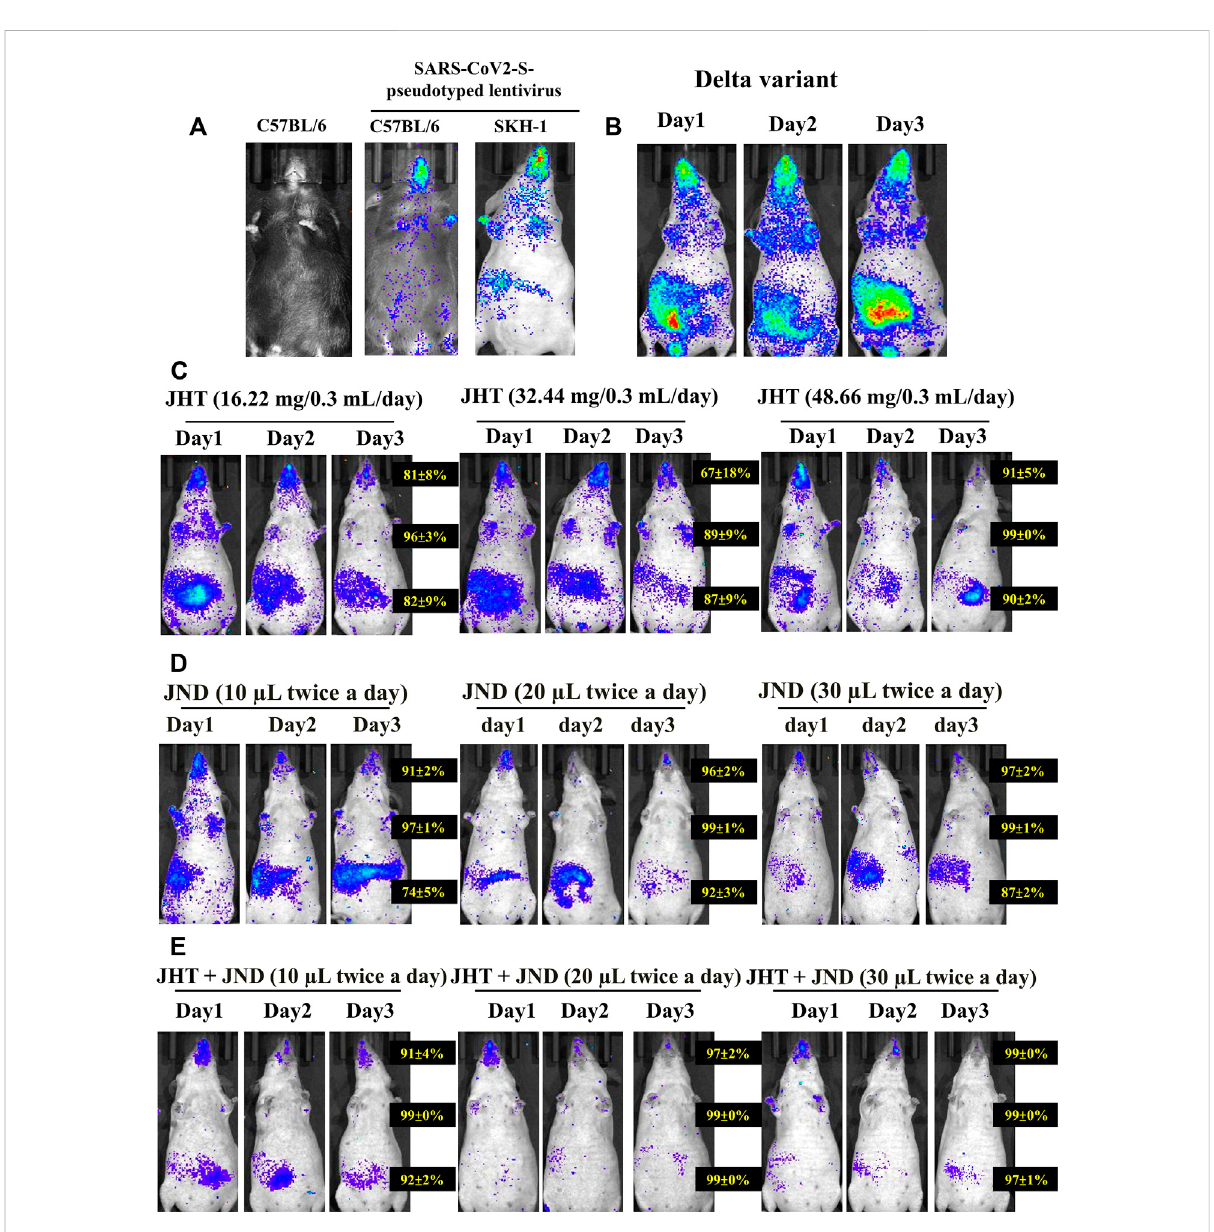
FIGURE 3 Effect of combined oral JHT and JND in reducing viral load in the thorax and in the abdomen. (A) Viral infusion shows variation in infection between C57BL/6 strains and SKH-1 strain of mice (n = 9) as seen from IVIS. (B) Infection with deltavariants infusedon Day 0and continued infusion for thenext3consecutive days.Time-dependent(1 day,2 days,and 3 days)and adose-dependentanalysis with 16.22 mg,32.44 mg,and 48.66 mg of JHT (C) and 10 μ L, 20 μ L, and 30 µL JND (D) and the effect of combined 48.66 mg JHT and different doses of JND (E) on the viral load in SKH-1